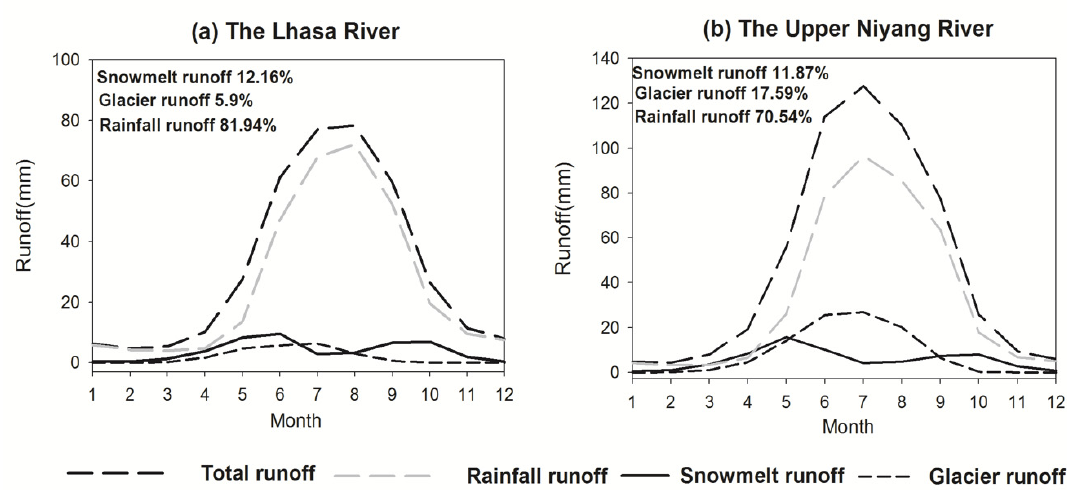
Figure 8. Seasonal distribution of total runoff, rainfall runoff, snowmelt runoff, and glacier runoff in the ( a ) LRB and ( b ) UNRB.